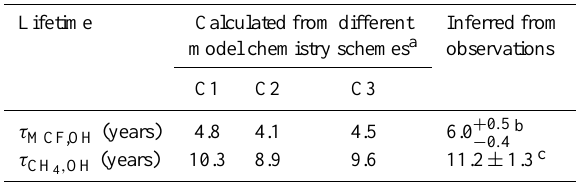
Table 3. Calculated present-day methyl chloroform (MCF)